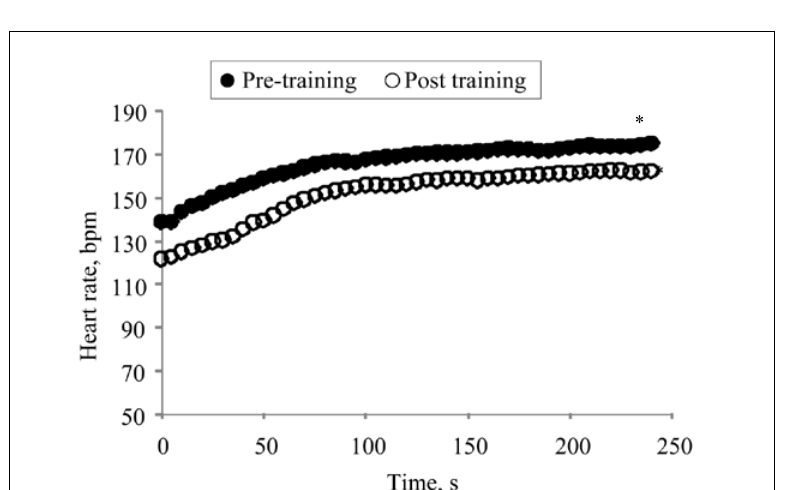
Table 3. The EMG parameters during interval endurance training every two weeks